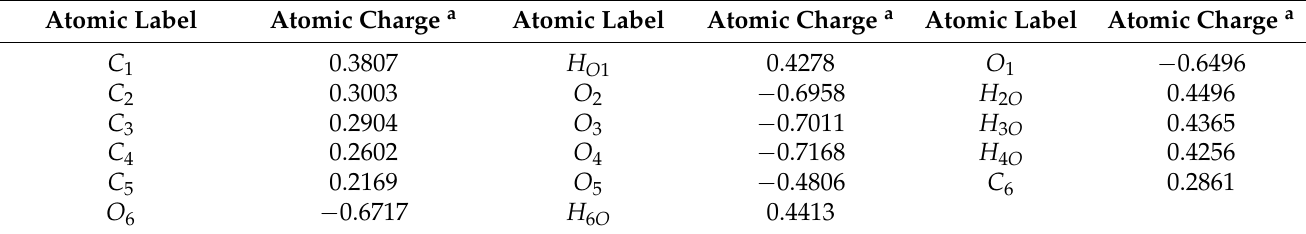
Table 1. Optimized atomic partial charges, excluding all aliphatic hydrogen atoms, for β -glucose. Atomic